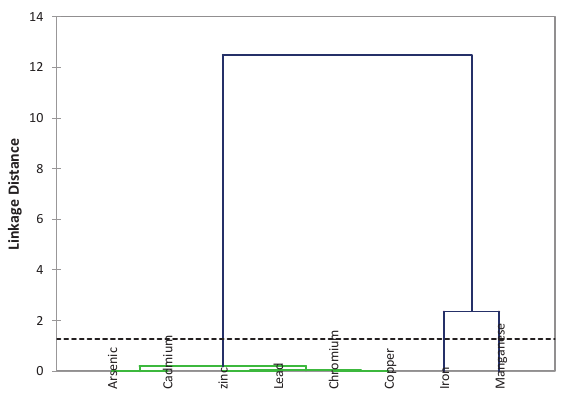
Figure 7: Dendrogram showing cluster analysis of heavy metals in the surface water samples from Ndawuse River based on the hierarchical cluster